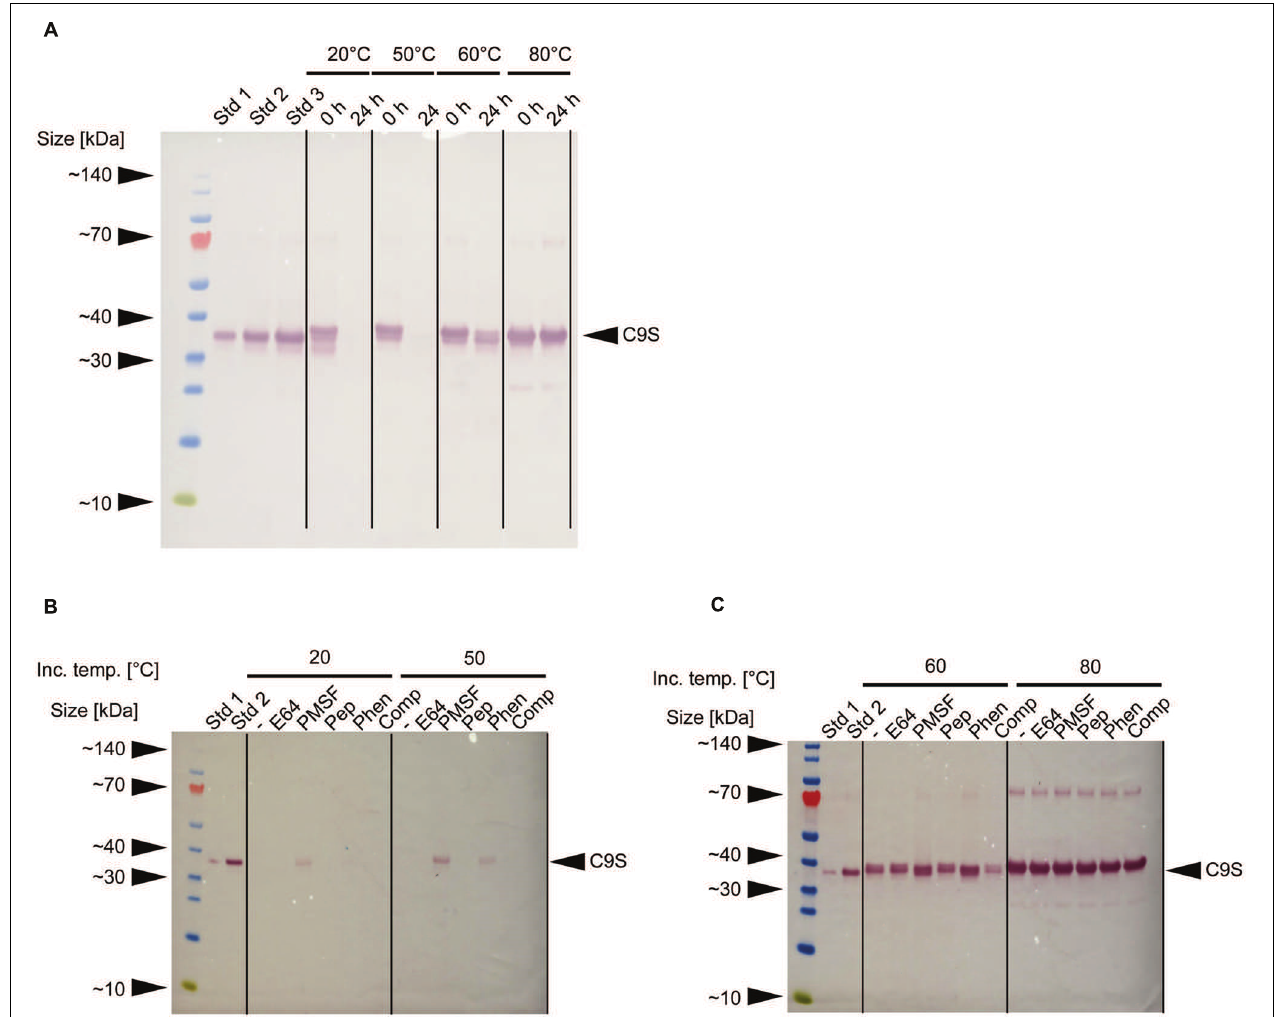
FIGURE 4 | Effect of heat treatment and protease inhibitors on the yield of malaria vaccine candidate C9S. (A) Immunoblot of C9S using a mouse-derived monoclonal primary antibody against Pf TRAP_TSR and alkaline phosphatase labeled goat-anti-mouse secondary antibody immediately after the heat treatment of plant extracts at different temperatures and after storage at RT for 24 h. (B,C) Immunoblots using the same antibodies as above, showing the effect of protease inhibitors on the yield of C9S after the plant extracts were treated at different temperatures and stored at RT for 24 h. Std 1–3 denote His 6 -tagged protein variants used for quantification: 83, 166, and 250 ng per lane (A) or 42 and 166 ng per lane (B,C)